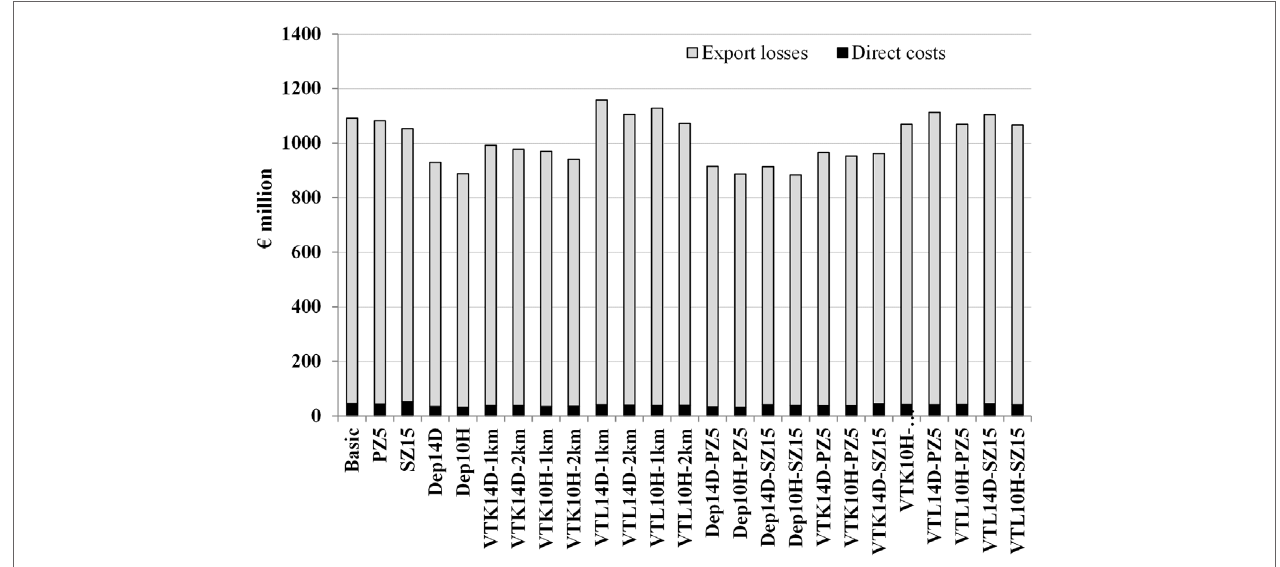
FigUre 2 | Median direct costs and export losses using different strategies to control 1,000 simulated FMD epidemics in Denmark, all initiated in cattle herds . The basic scenario represents the EU and Danish control measures (Basic), combined with the enlargement of the protection zone to 5 km (PZ5) and the surveillance zone to 15 km (SZ15), pre-emptive depopulation (Dep) over a 1-km radius around detected herds, and suppressive (VTK) or protective (VTL) emergency vaccination over a 1- or 2-km radius around detected herds. Pre-emptive depopulation and vaccination were initiated either following the detection of 10 infected herds (10H) or after 14 days (14D) from the detection of the first infected herd. Scenarios combining pre-emptive depopulation over 1 km, suppressive or protective emergency vaccination over 2 km and enlarged protection or surveillances zones are also included.